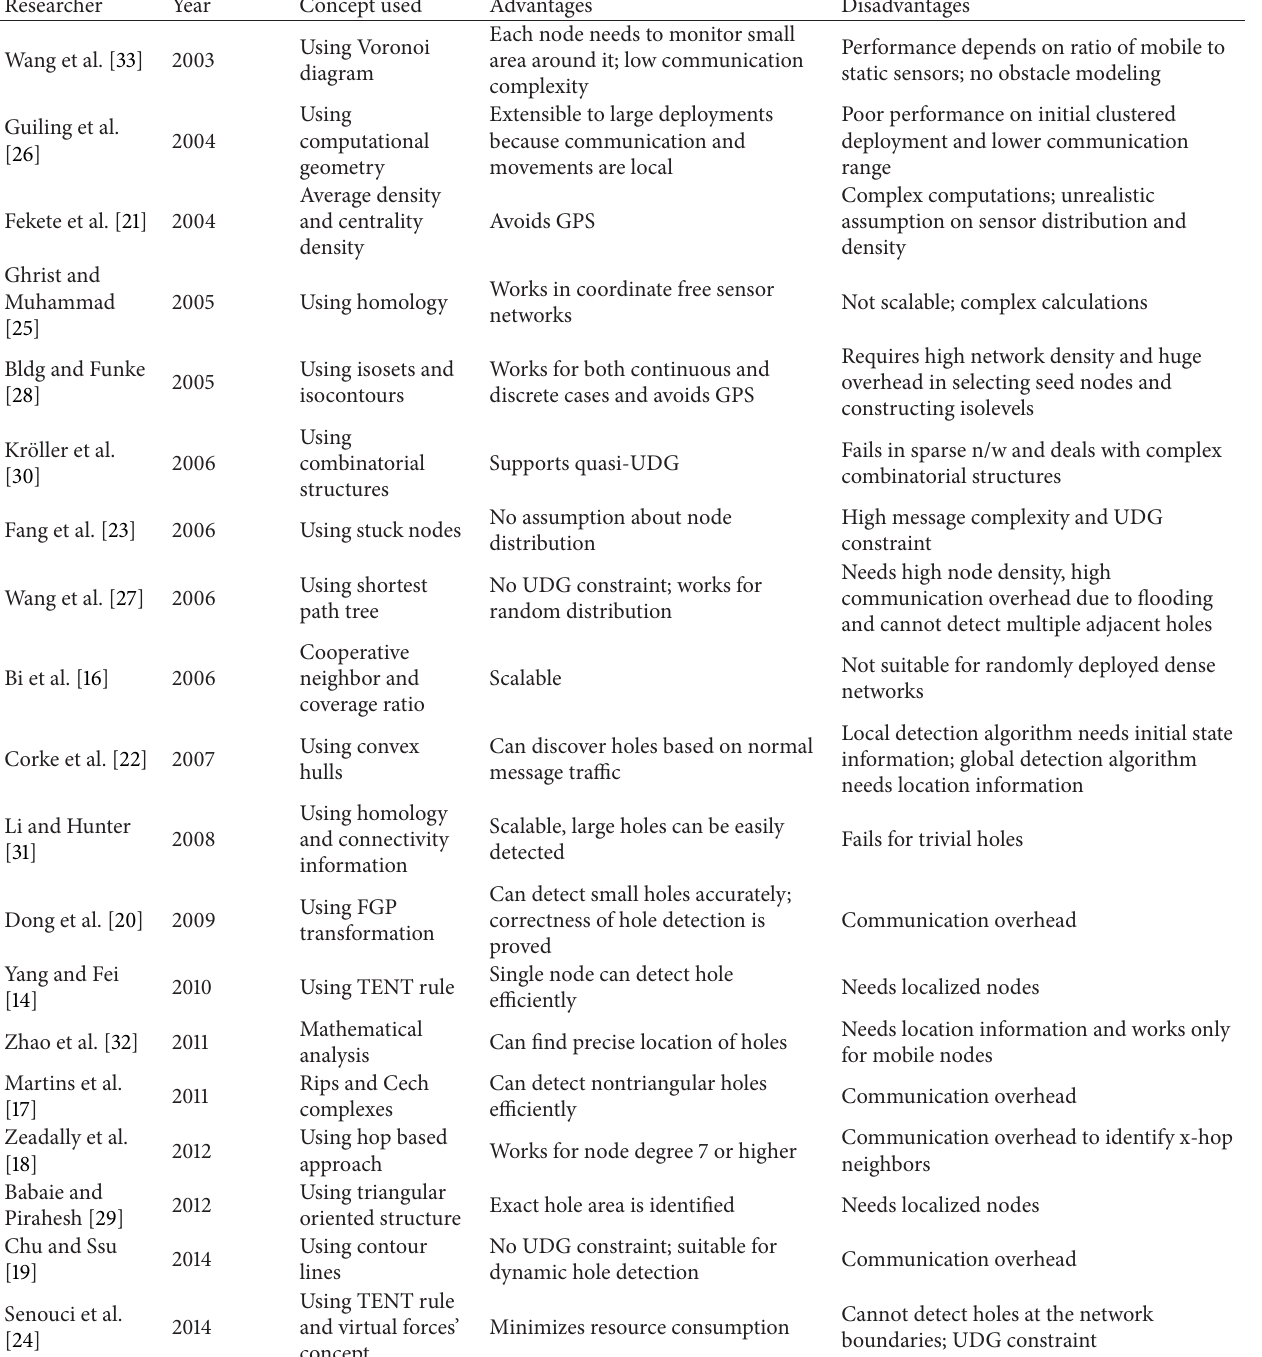
Table 2: Strengths and shortcomings of coverage hole detection